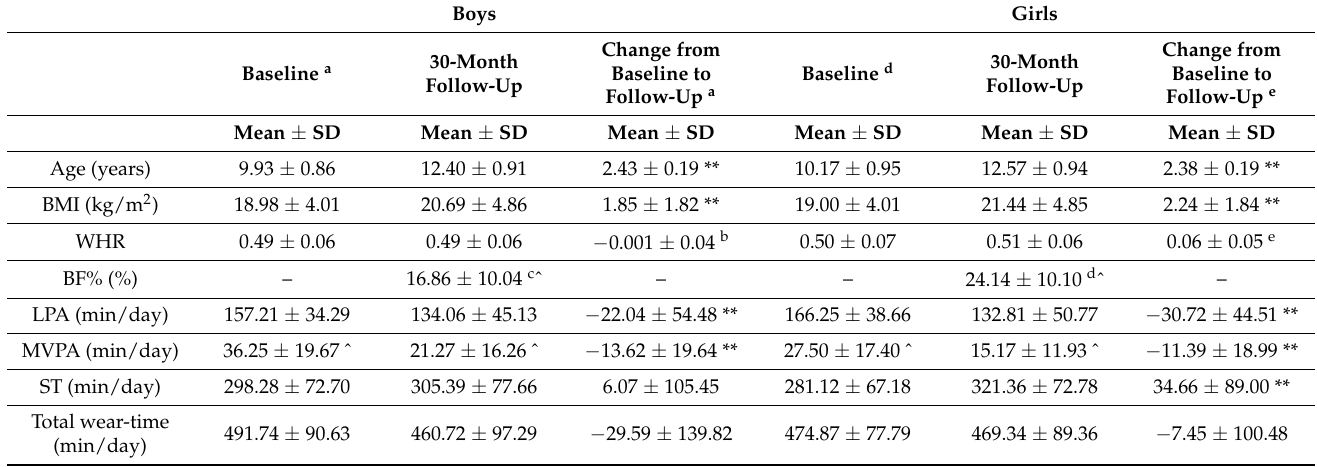
Table 1. Participant characteristics for the analytic sample ( n = 142; boys n = 65; girls n = 77). Boys